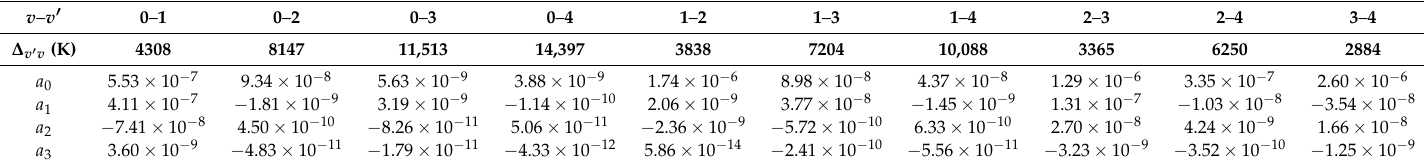
Table 5. Same as Table 3 for 3 HeH + .